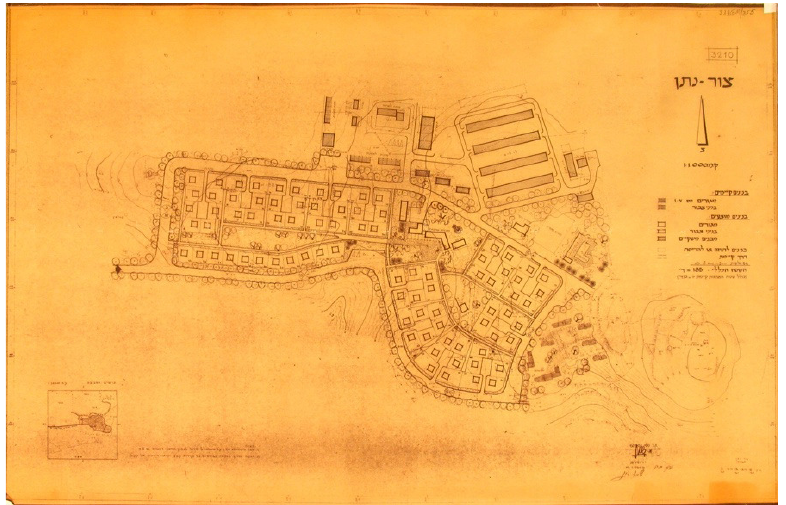
Figure 6. Tzur‐Nathan. Source: The Jewish Agency for Israel